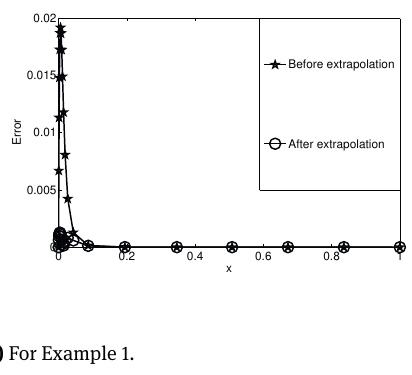
Fig. 2: Error behaviour with N = 20 and ε = 10 −2 .